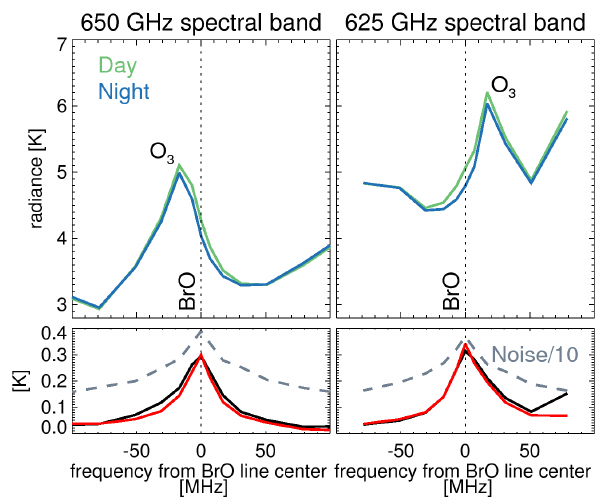
Fig. 1. Top: average MLS radiance as detected in the 650 and 625Ghz spectral bands sorted into day (blue) and night (green) time measurements. Average is from 55 ◦ S and 55 ◦ N and for limb tan- gents from 10 to 4.6hPa for 2005. Bottom: differences between the ascending and descending (mainly day and mainly night) measure- ments (black) reveals the BrO spectral signature. The red lines rep- resent the spectrum simulated by using the new averaged BrO re- trieved value introduced here. The dashed gray line is 1/10 of the expected single scan